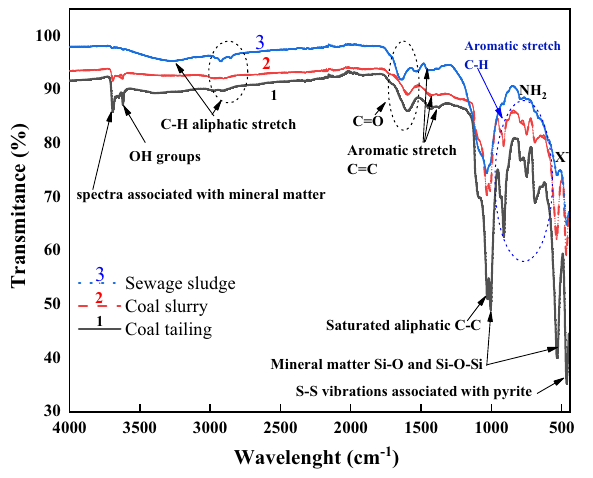
Figure 4. FTIR spectrum of raw samples.